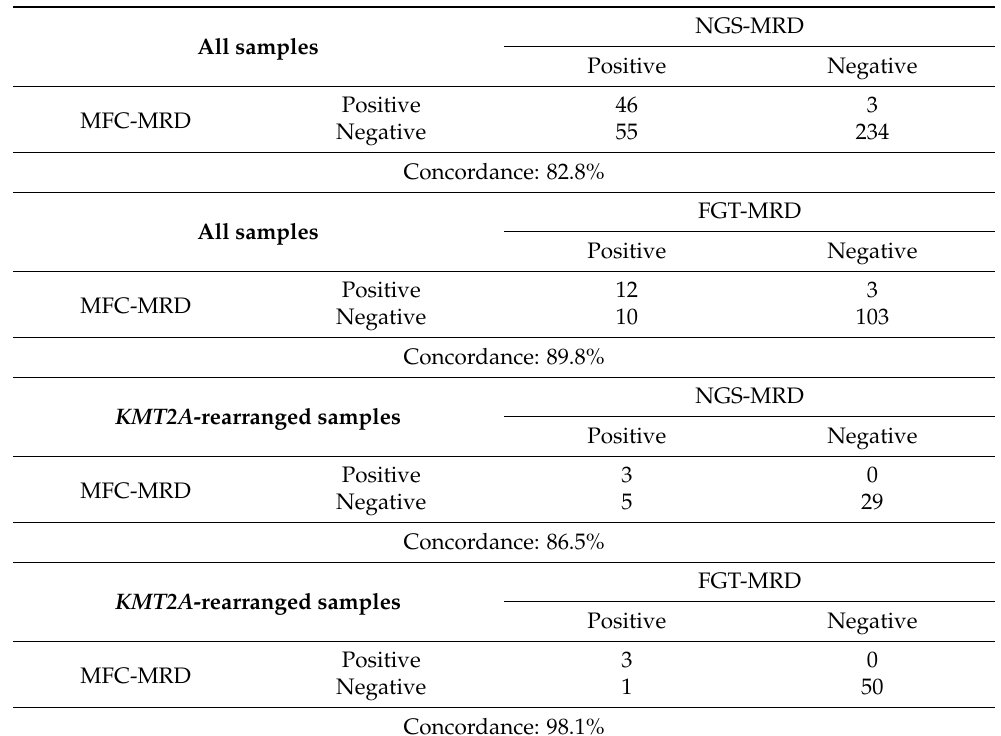
Table 3. Qualitative concordance between MFC-MRD and NGS-/FGT-MRD results in all samples and in samples with KMT2A -rearranged